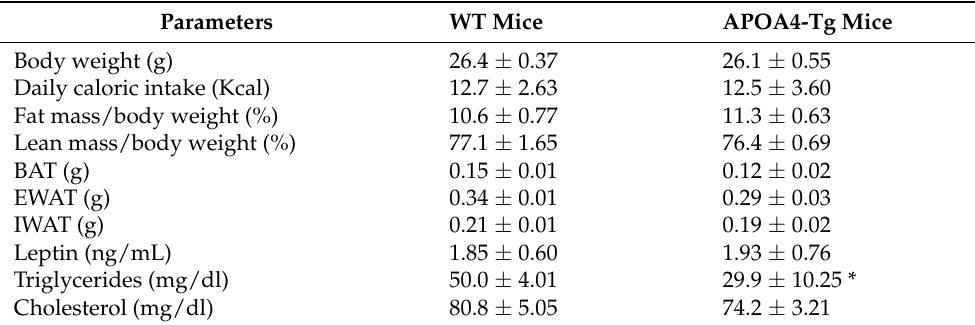
Table 1. Body weight, fat mass, and levels of plasma parameters in chow-fed